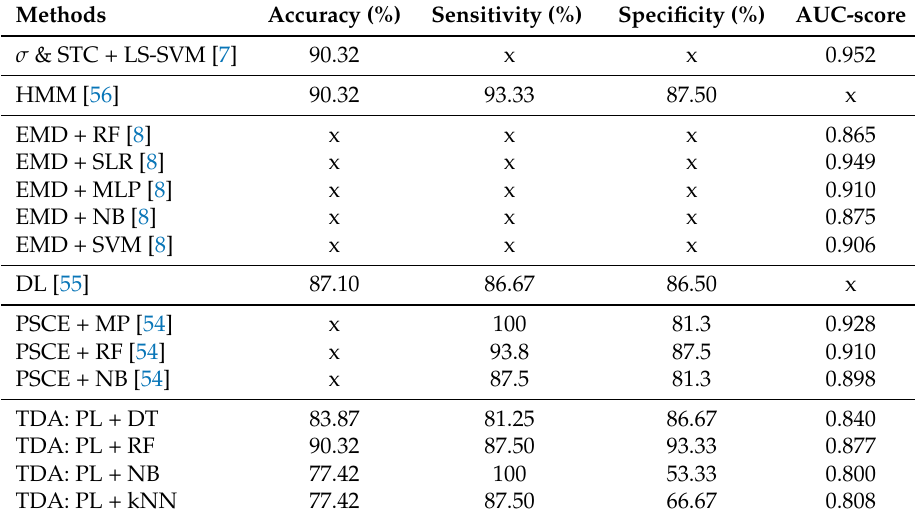
Table 8. Comparisons of AUC and LOO-CV Results for classification of HC and PD